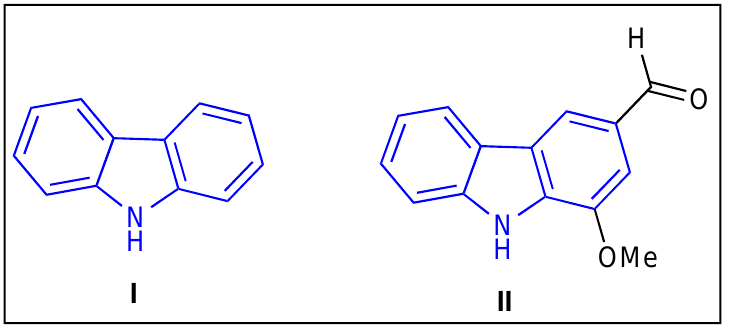
Figure 1. Structure of 9 H -carbazole ( I ) and its analog murrayanine ( II ). Therapeutically important natural carbazoles have inspired synthetic medicinal chemists to design and develop novel (semi)synthetic carbazole derivatives. The carbazole moiety is present in several important commercially available drug molecules such as ellipticine ( III ), alectinib ( IV ), midostaurin ( V ), carvedilol ( VI ), carazolol ( VII ), carprofen ( VIII ), and frovatriptan ( IX ) (Figure 2). The naturally occurring alkaloid ellipticine ( III ) was first dis- covered in 1959 as an anticancer agent. It was extracted from the leaves of Ochrosia elliptica and is considered to be one of the initial leading therapeutic carbazole analogs for the treatment of cancer [21]. Alectinib ( IV ) was approved by the FDA in 2015 for the treatment of advanced non-small cell lung cancer (NSCLC) [22]. Midostaurin ( V ) was permitted by the FDA in 2017 for the treatment of newly diagnosed acute myeloid leukemia (AML) and for advanced systemic mastocytosis (SM) [23,24].